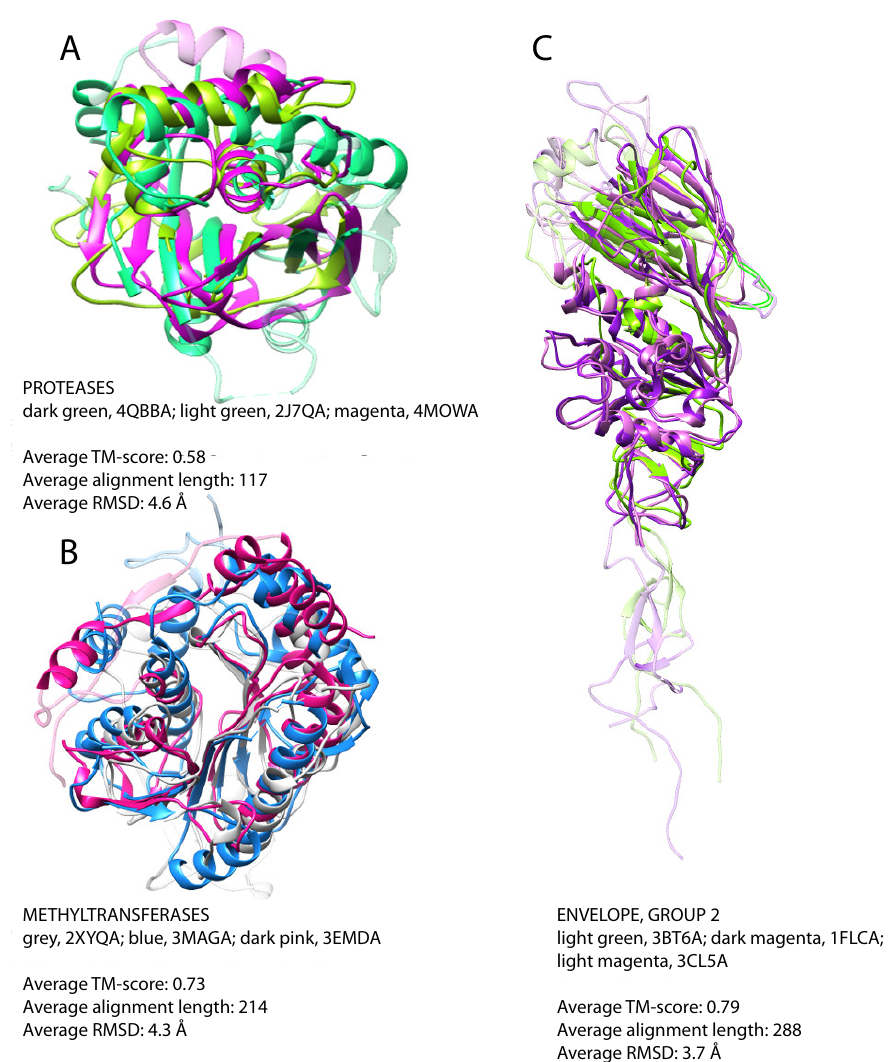
Figure 4. Confined folds, superposition of representative structures. ( A ) Protease domains of leader protease from foot and mouth disease virus, strain O1, positive-strand ssRNA (dark green), ubiquitin specific protease from murine herpesvirus 1, dsDNA (light green), papain-like protease from SARS coronavirus, positive-strand ssRNA (magenta); ( B ) mRNA cap-specific methyltransferase VP39 from Vaccinia virus, dsDNA (blue), putative 2’-O-methyl transferase from SARS coronavirus, positive-strand ssRNA (grey), methyltransferase from the Wesselsbron virus, positive-strand ssRNA (dark pink); ( C ) hemagglutinin-esterase-fusion glycoproteins of influenza C virus, strain C/Johannesburg/1/66, negative-strand ssRNA (dark magenta), influenza B virus, strain B/Memphis/13/2003, negative-strand ssRNA, (light green), bovine coronavirus, positive-strand ssRNA (light magenta). For clarity, non-superimposable loops were